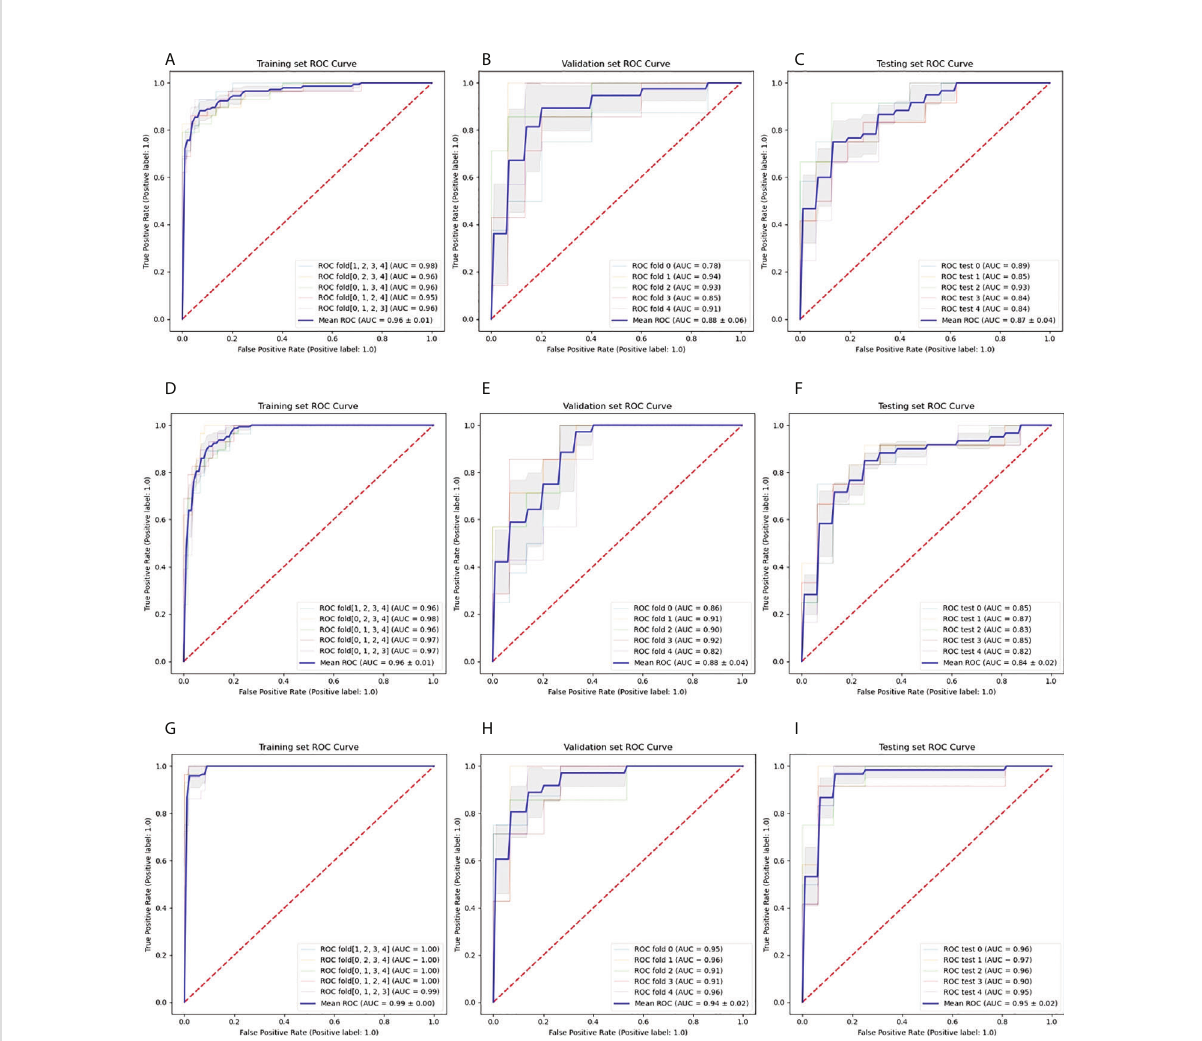
FIGURE 5 Roc curves of 3D CNN models. (A – C) represented AP model in training (A) , validation (B) , and test (C) groups, and (D – F) represented VP model in training (D) , validation (E) , and test (F) groups, and (G – I) represented AP+VP model in training (G) , validation (H) , and test (I) groups. Every fi gure demonstrated model performance under 5-fold cross-validation.